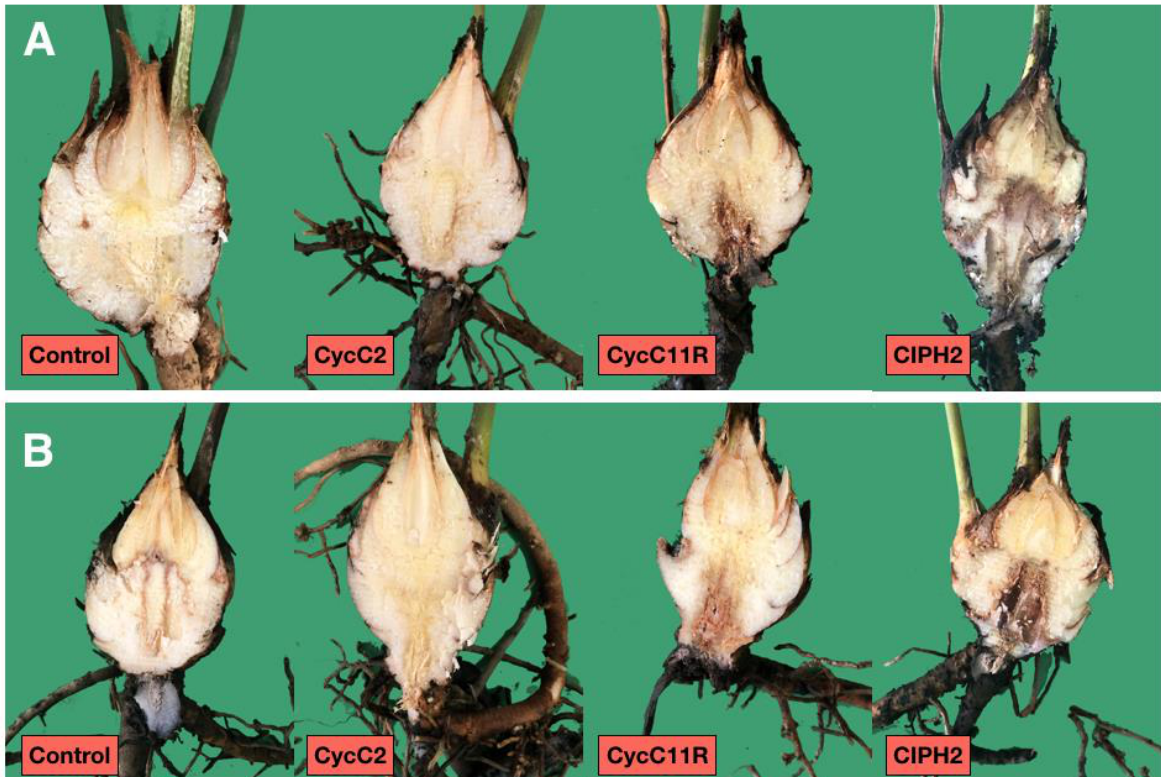
Figure 6. Internal stem necrosis from representative samples of Cycas revoluta plants from two separate experiments, the soil-infestation test ( A ) and the wound-inoculation test ( B ) with Phytophthora pseudocryptogea (CIPH2) and P. nicotianae (CycC11R), observed at the end of the two experiments (60 dpi). No symptoms appear in the stems inoculated with P. multivora (CycC2) in both tests. Stem from the control plants (control) remained asymptomatic.